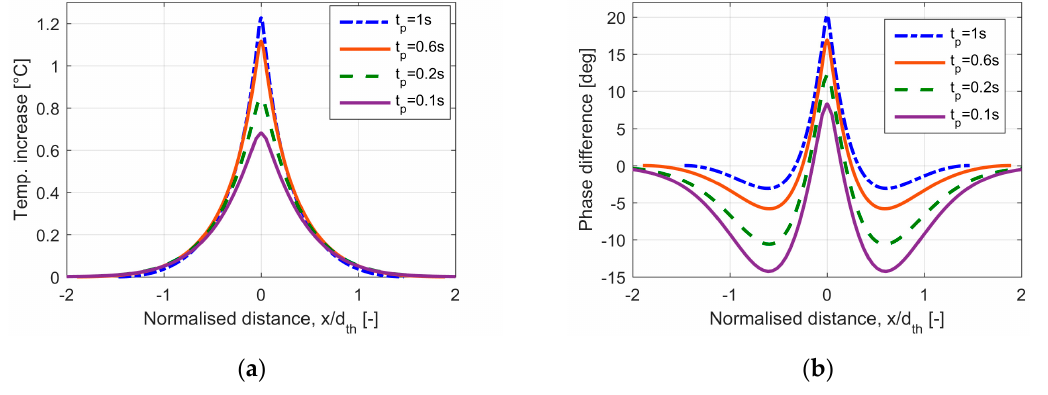
Figure 4. Temperature ( a ) and phase difference ( b ) around a crack ( d = 1 mm) as shown in previous figures, calculated for different pulse lengths using the simu.2 model.